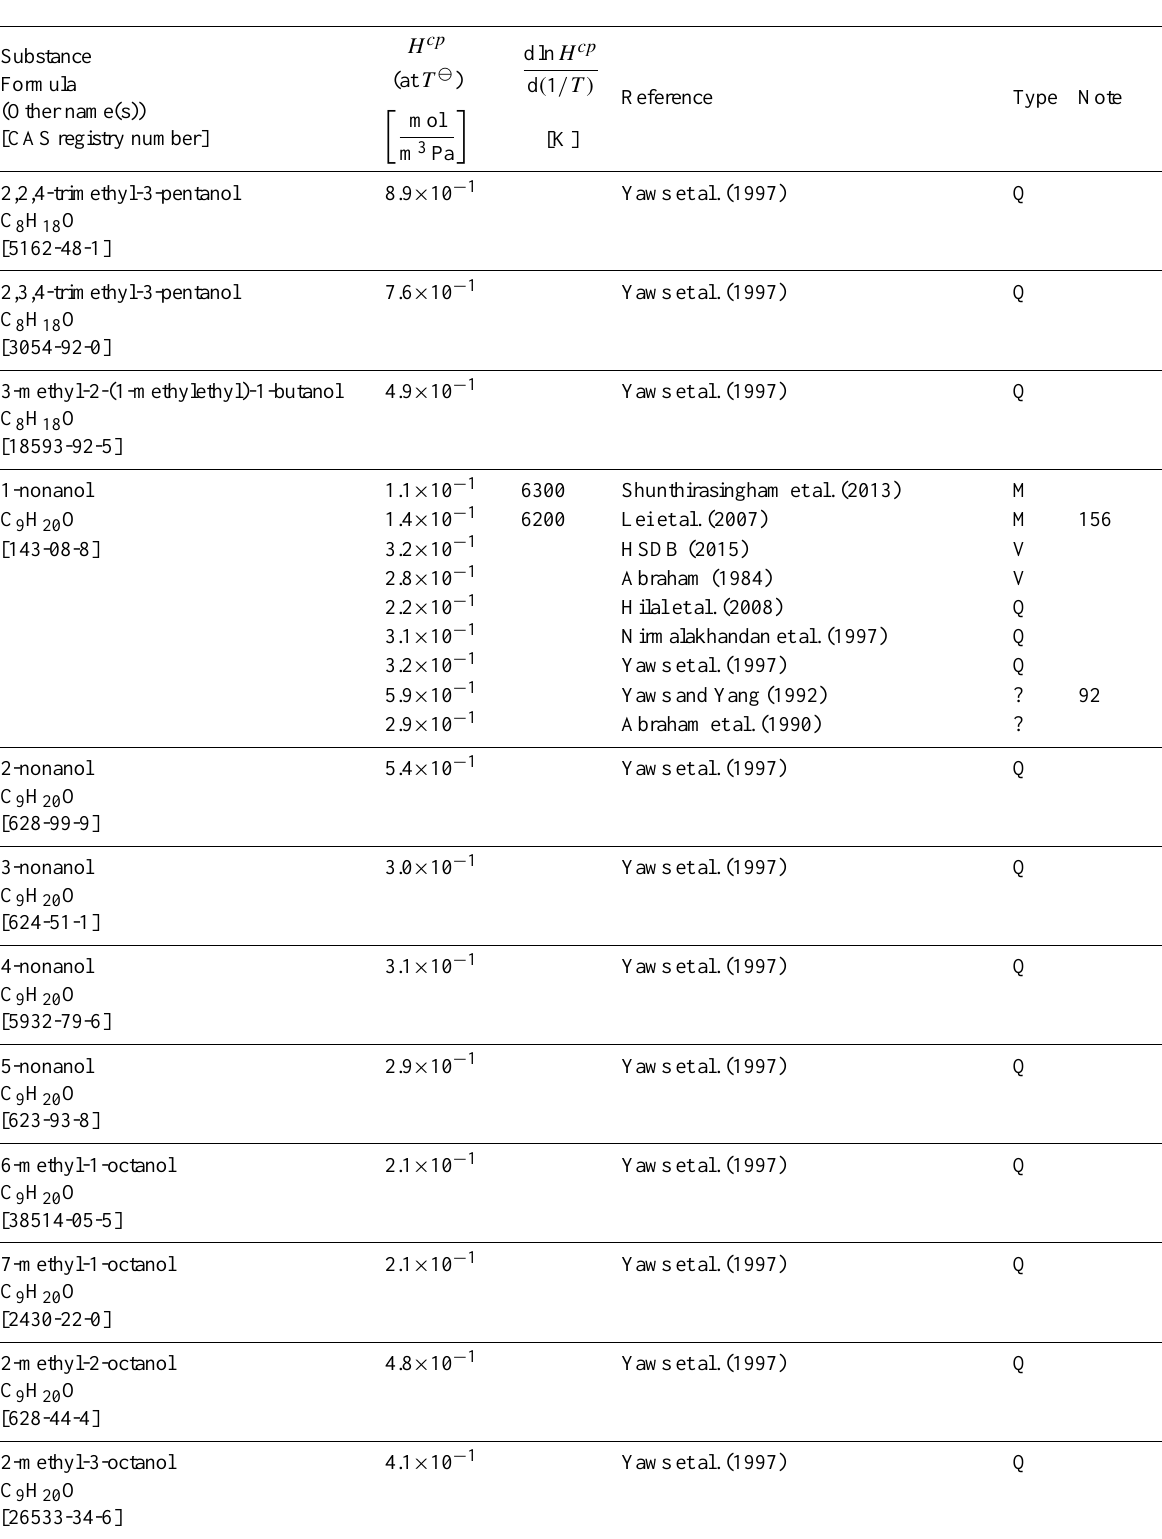
Table 6: Henry’s law constants for water as solvent